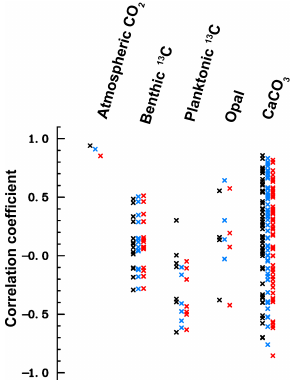
Figure 11. Correlation coefficients between observations and pre- dicted tracer values from the linear response model. The correlation coefficients are shown from left to right for the various tracer types. Each record is represented by one small cross. Values for the full rank solution are given in black, values for rank 7 in blue, and val- ues for rank 6 in